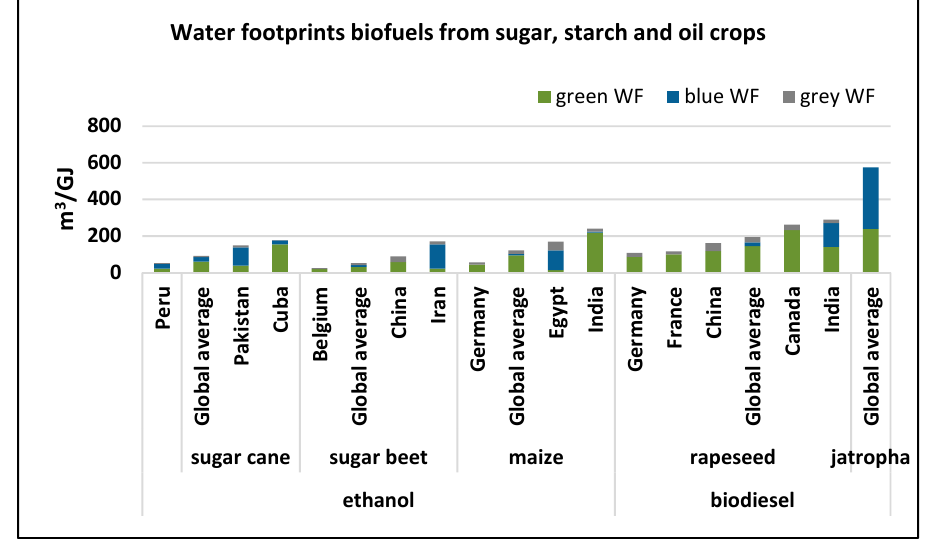
Figure 1. Water footprints (WFs) of biofuels from the main sugar, starch and oil crops (sugar cane, sugar beet, maize and rapeseed) for a selection of countries with large WF differences. The figure also gives the global average WFs (Source [6,7]).